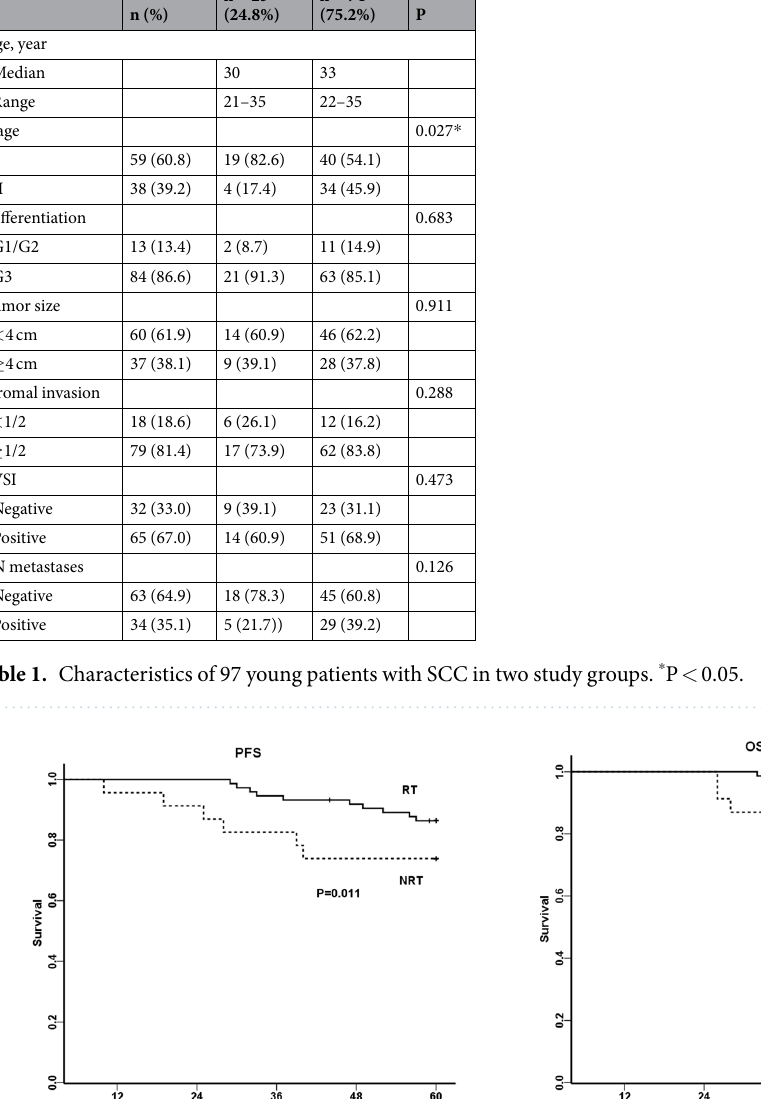
There were significant statistical differences in the QoL issues, including physical function, emotional func- tion, constipation, financial difficulties, and global health status between the two modalities (Table 5). The NRT group scored higher on the scale of global health status than the RT group (72.10 ± 14.78 vs. 64.30 ± 16.35, P = 0.044). In functional scales, physical function (NRT vs. RT = 71.30 ± 18.90 vs. 61.80 ± 19.28, P = 0.043) and emotional function (NRT vs. RT = 68.12 ± 16.98 vs. 59.12 ± 16.15, P = 0.023) had minimal differences. Meanwhile, in symptom scales/items, diarrhea (NRT vs. RT = 72.46 ± 23.89 vs. 52.70 ± 33.11, P = 0.009) and financial difficulties (NRT vs. RT = 85.51 ± 16.89 vs. 62.16 ± 34.16, P = 0.002) were significantly different.